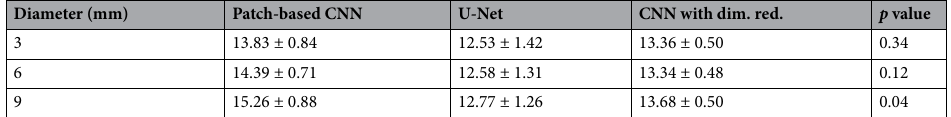
Table 3. Results for multiple splits of the image data. Presented is the mean absolute error ± standard deviation in μm over 3 unique test sets. p values were calculated by one-way ANOVA and represent the chance that model performances are